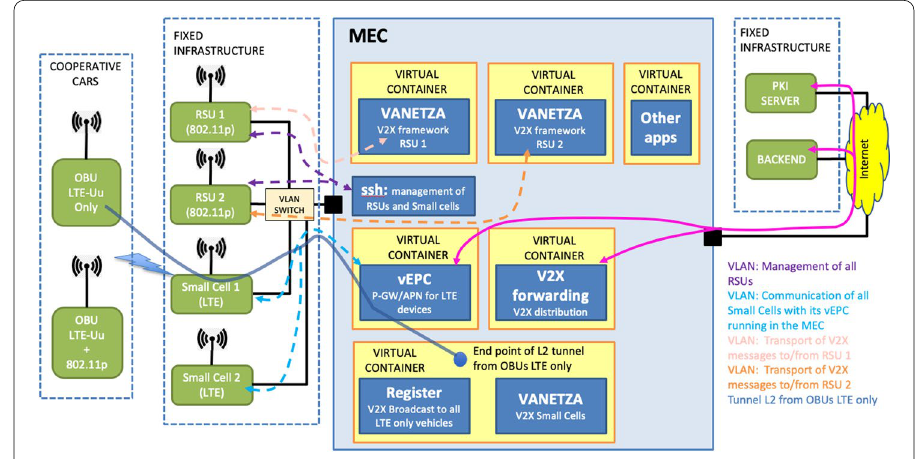
Fig. 2 Proposed network